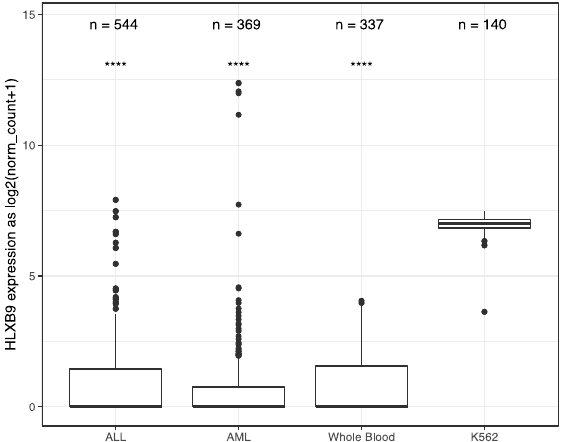
Figure 1. HLXB9 expression-level distribution in acute myeloid leukemia (AML), acute lymphoblastic leukemia (ALL), whole blood and K562 leukemia cell line. The number of samples in each dataset is given above. Whole blood and K562 samples were extracted from Genotype-Tissue Expression (GTEx). AML is a composite dataset combining cross-project normalized samples from The Cancer Genome Atlas (TCGA)(173 samples) and the Therapeutically Applicable Research to Generate Effective Treatments (TARGET) (196 samples). **** p< 0.0001 .